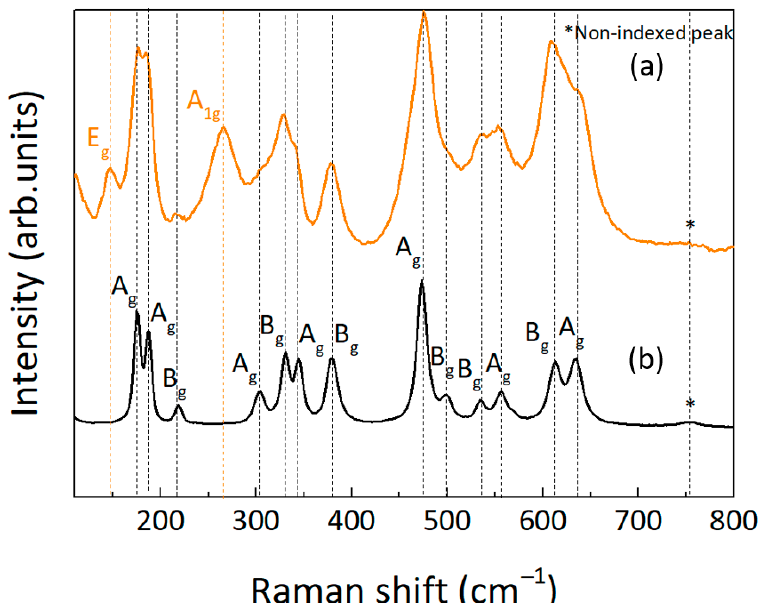
Figure 2. Raman spectra of the synthesized ZrO 2 nanopowders: ( a ) before and ( b ) after calcination at 800 °C for 15 min. The black and orange vertical dash lines represent the expected frequencies for the monoclinic and tetragonal ZrO 2 , respectively, and according to [77,79,81].